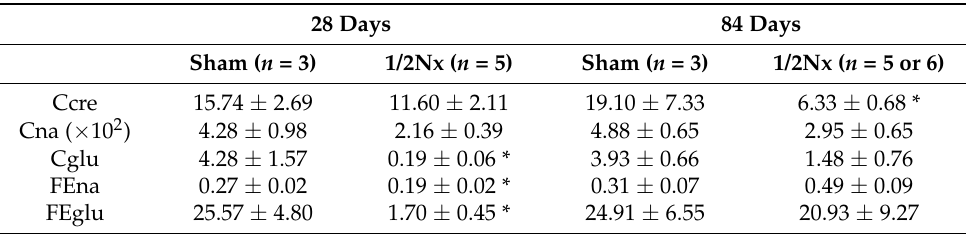
Table 5. Creatinine, sodium, and glucose clearances and fraction excretions in Sham operated and 1/2Nx DEK